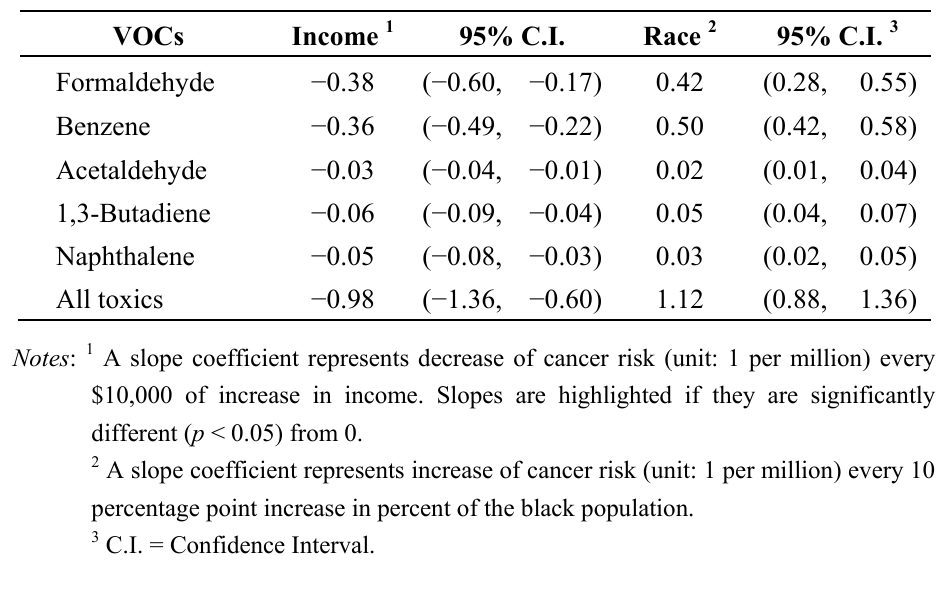
Table 1. Effects of household income and race on cancer